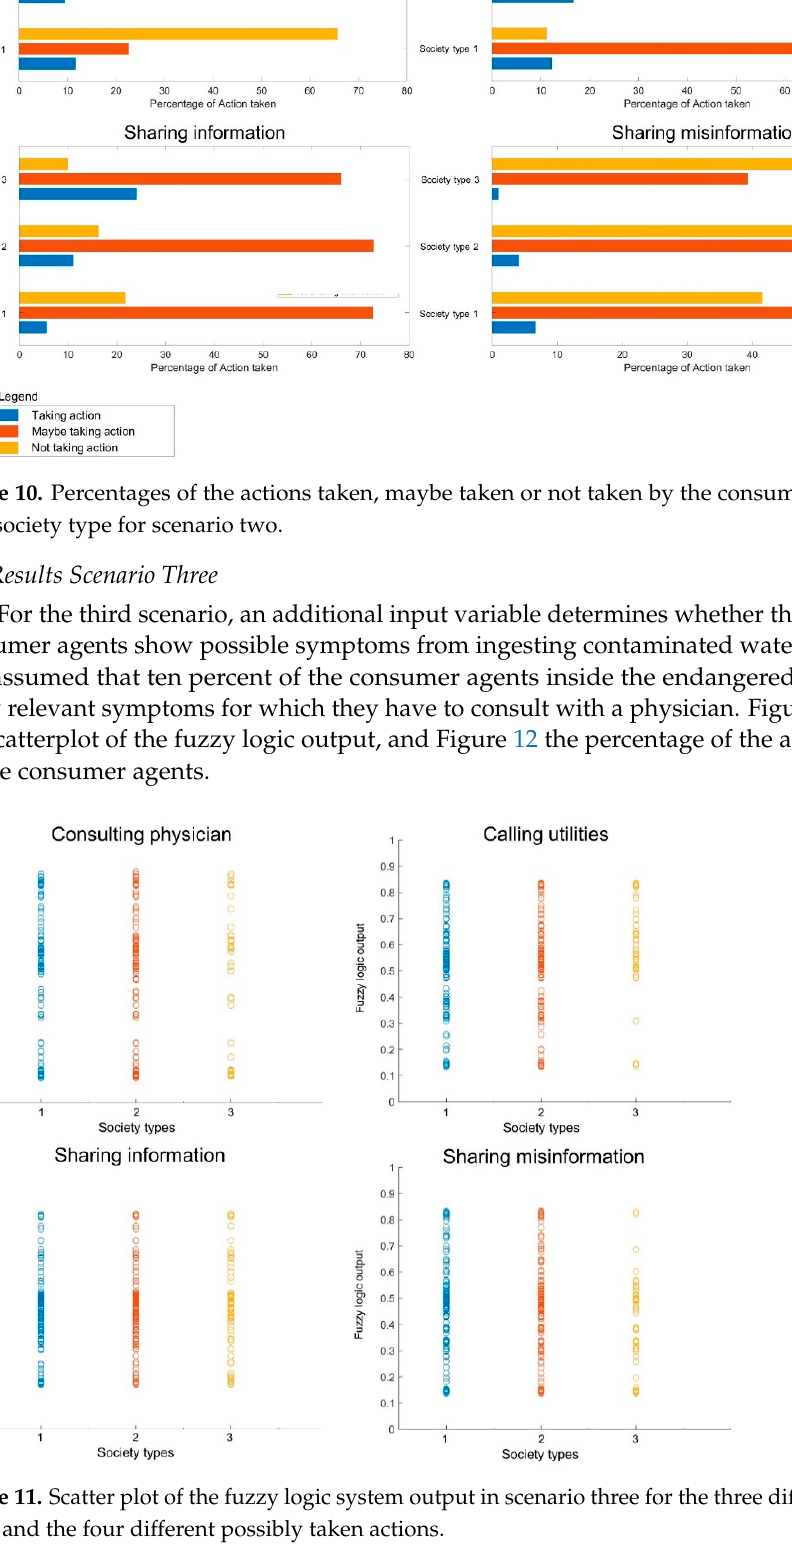
Figure 12. Percentages of the actions taken, maybe taken or not taken by the consumer agents for each society type for scenario three. 5. Conclusions Prior work has documented the use of inline mobile sensors during contamination events in a WDS as well as the utilisation of agent-based modelling for exploring, e.g.,